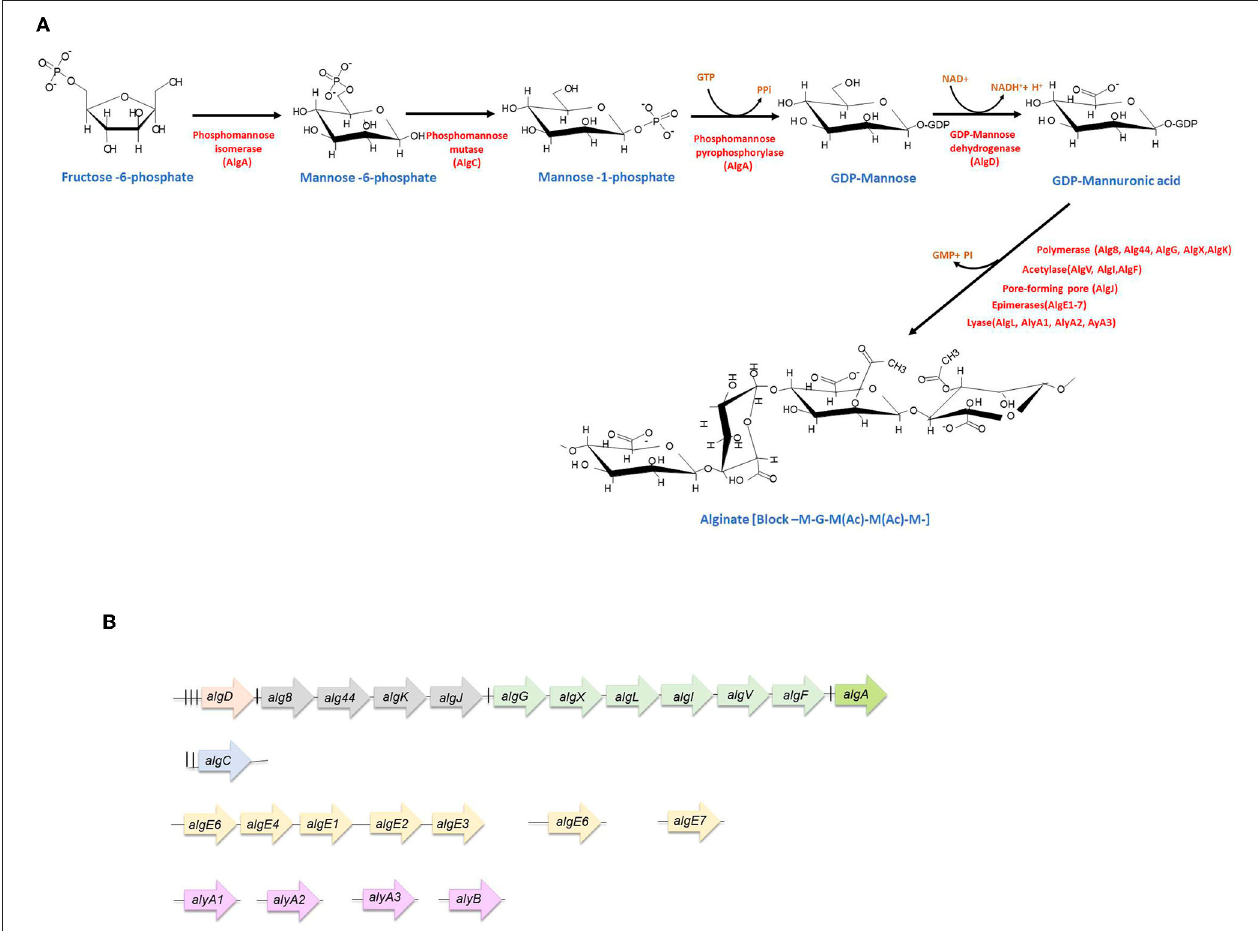
FIGURE 1 | Alginate synthesis in Azotobacter vinelandii . (A) Biosynthetic pathway. The enzymes (red) as well as the substrates (blue) for alginate production are indicated. (B) Genetic arrangement of alginate biosynthetic genes. The experimentally determined promoters are indicated by vertical black lines. algD transcription starts from three promoters (for details, see the text). The nature of the internal promoters upstream alg8, algG , and algA is unknown. Genes are not shown at scale.